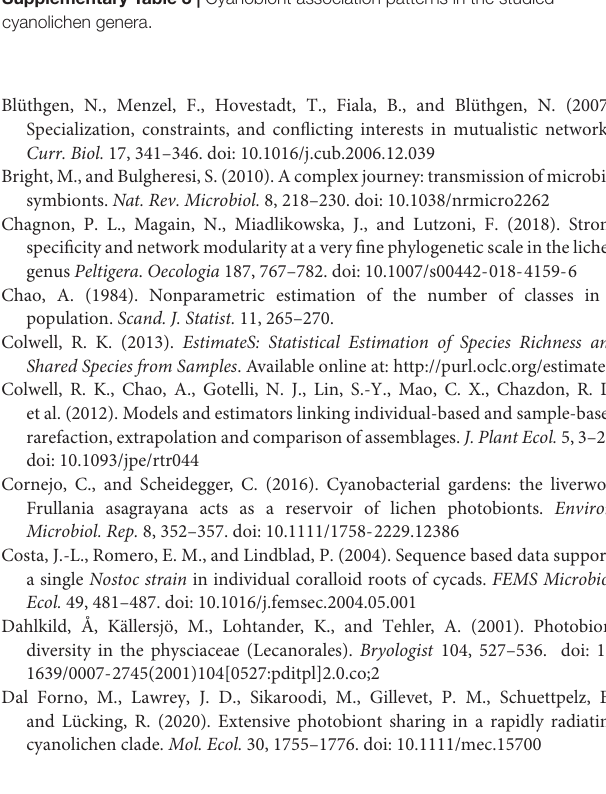
Supplementary Figure 1 | Map of collection locations. Supplementary Figure 2 | Median-joining networks of the cyanobacterial trnL variants. Supplementary Table 1 | Lichen specimens. Supplementary Table 2 | Lichen species and their attributes. Supplementary Table 3 | Cyanobiont association patterns in the studied cyanolichen